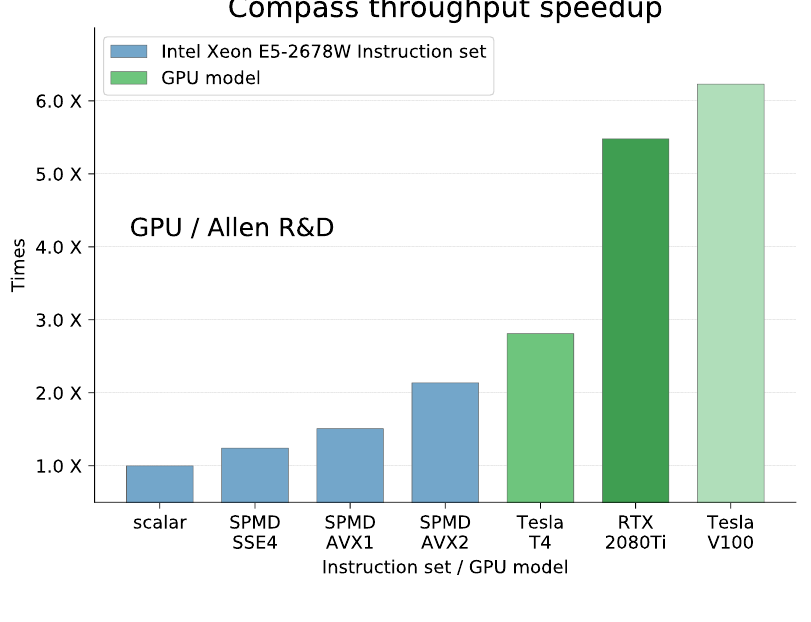
Figure 4. Performance